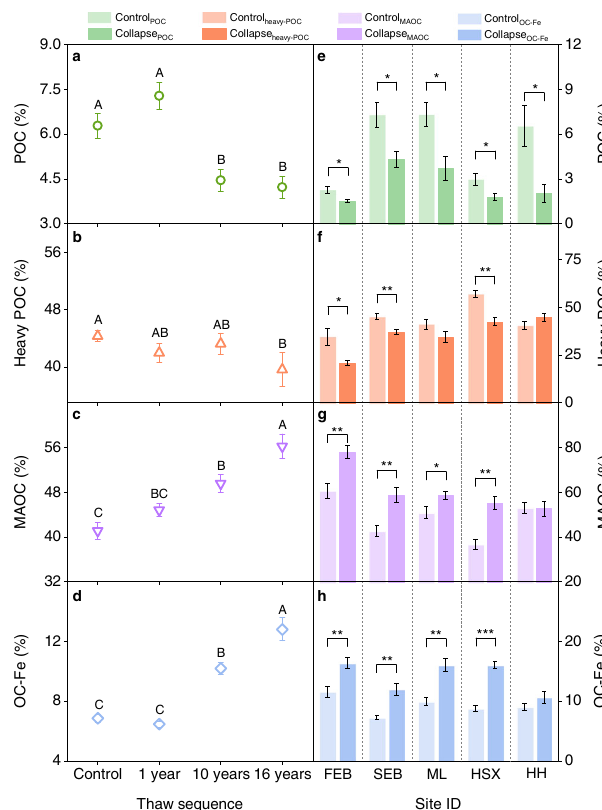
Fig. 3 | Changes in the proportion of soil C fractions to SOC after permafrost collapse. a – d Variations of the proportion of POC ( a ), heavy POC ( b ), MAOC ( c ), andOC-Fe( d )toSOCalongthethawsequence. e – h Comparisonsofthepercentage ofPOC( e ),heavyPOC( f ),MAOC( g ),andOC-Fe( h )betweencollapsed(darkcolor) and control (light colour) plots in each site at the regional scale. SOC, soil organic carbon; POC, particulate organic carbon (density<1.6gcm − 3 ); Heavy POC, heavy particulate organic carbon (density>1.6gcm − 3 and size>53 μ m); MAOC, mineral- associated organic carbon (density>1.6gcm − 3 and size<53 μ m); OC-Fe, iron- boundorganiccarbon;FEB,the fi rstsiteatEbo;SEB,thesecondsitelocatedatEbo; ML, HSX, and HH indicate the sites at Mole, Huashixia, and Huanghe, respectively. Error bars represent standard errors. Different capital letters indicate signi fi cant differences for the variables within plots along the thaw sequence (LSD test, P <0.05). Dashed lines distinguish different thermokarst-impacted sites,